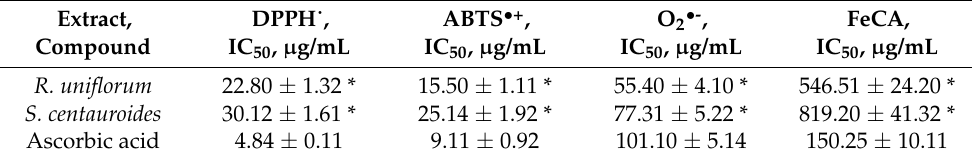
Table 3. Radical-scavenging activity of R. uniflorum and S. centauroides herb extracts in vitro .